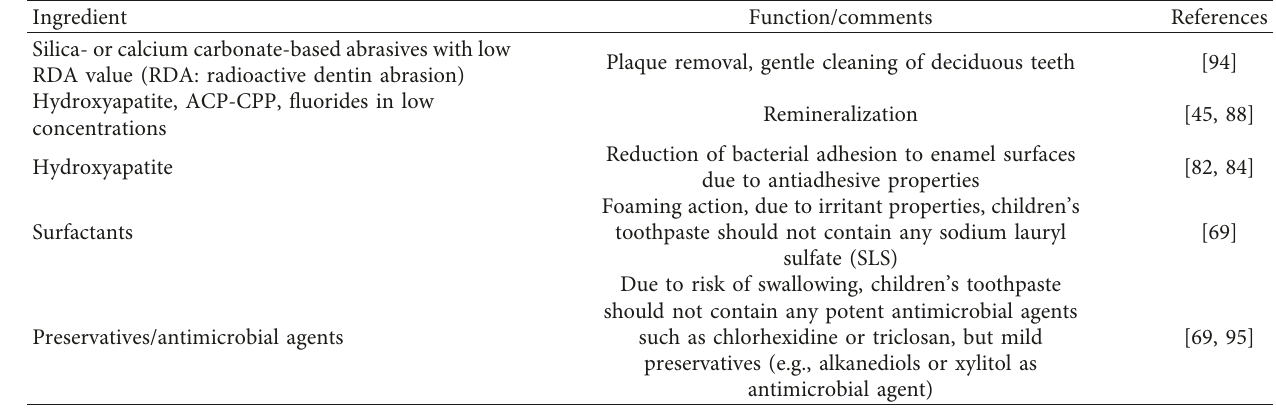
Table 1: Main ingredients for children’s toothpastes (up to 6